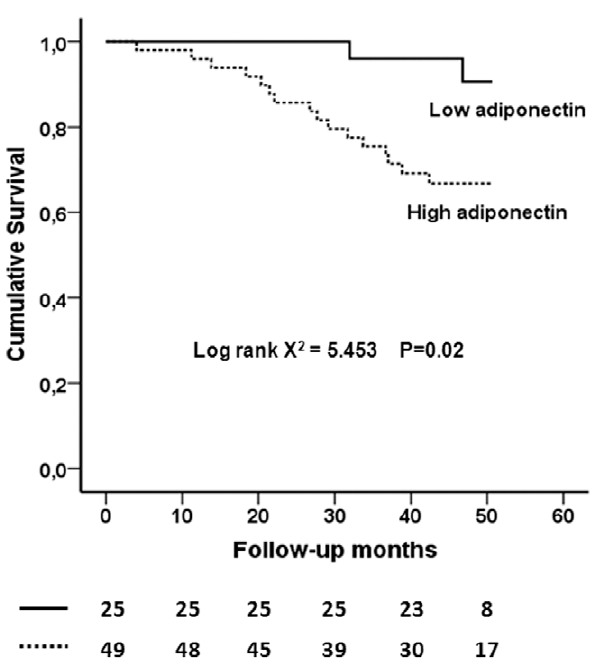
Figure 1. Kaplan-Meier analyses comparing the lowest sex- specific tertile of adiponecting ( , 14 for men and , 18 m g/ml for women) to the higher (middle and highest) tertiles. The number of patients at risk are given below the